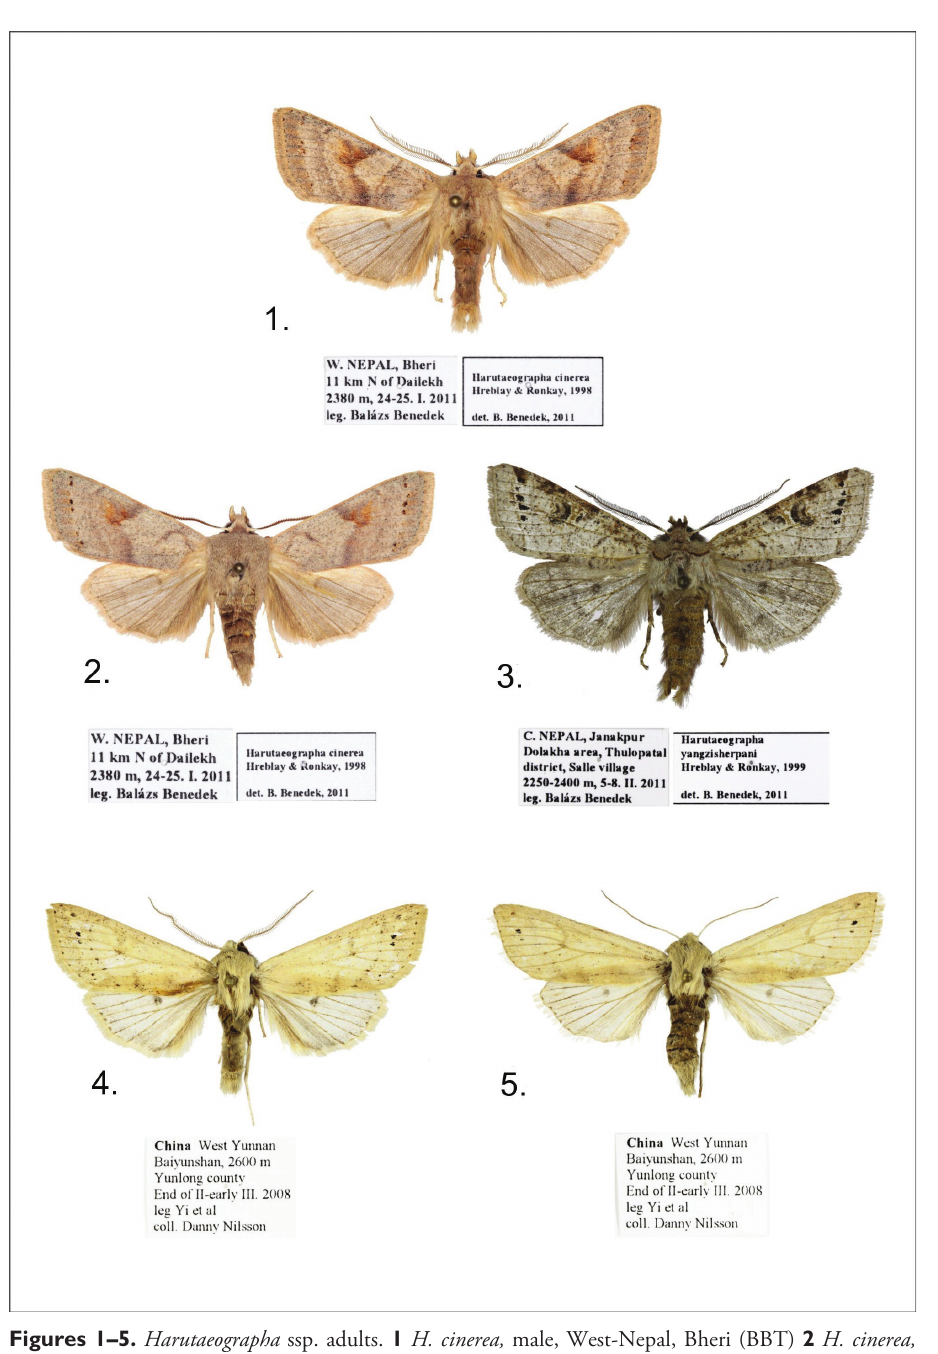
Figures 1–5. Harutaeographa ssp. adults. 1 H. cinerea, male, West-Nepal, Bheri (BBT) 2 H. cinerea, female, West-Nepal, Bheri (BBT) 3 H. yangzisherpani yangzisherpani, male, Nepal, Janakpur (BBT) 4 H. monimalis, male, China, W. Yunnan (DNK) 5 H. monimalis, female, China, W. Yunnan